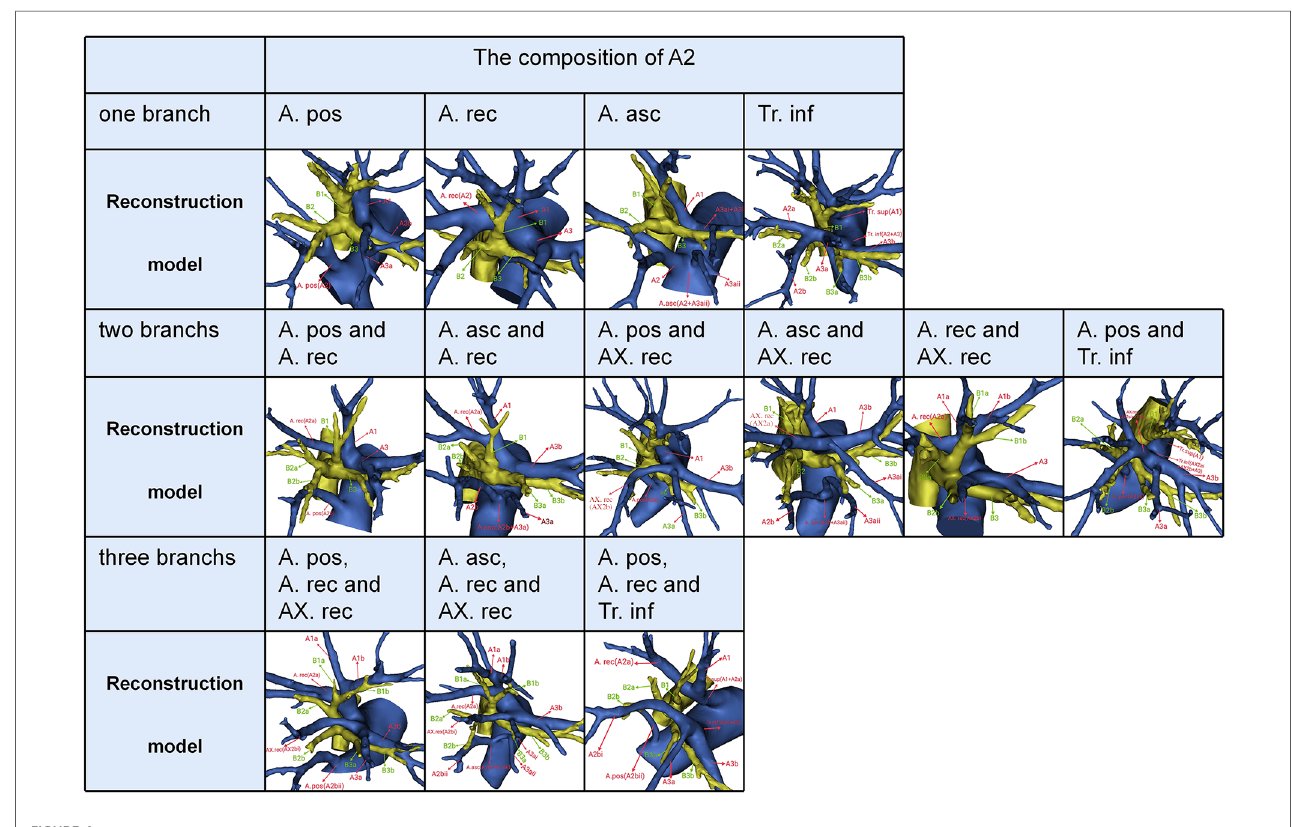
FIGURE 4 The composition of